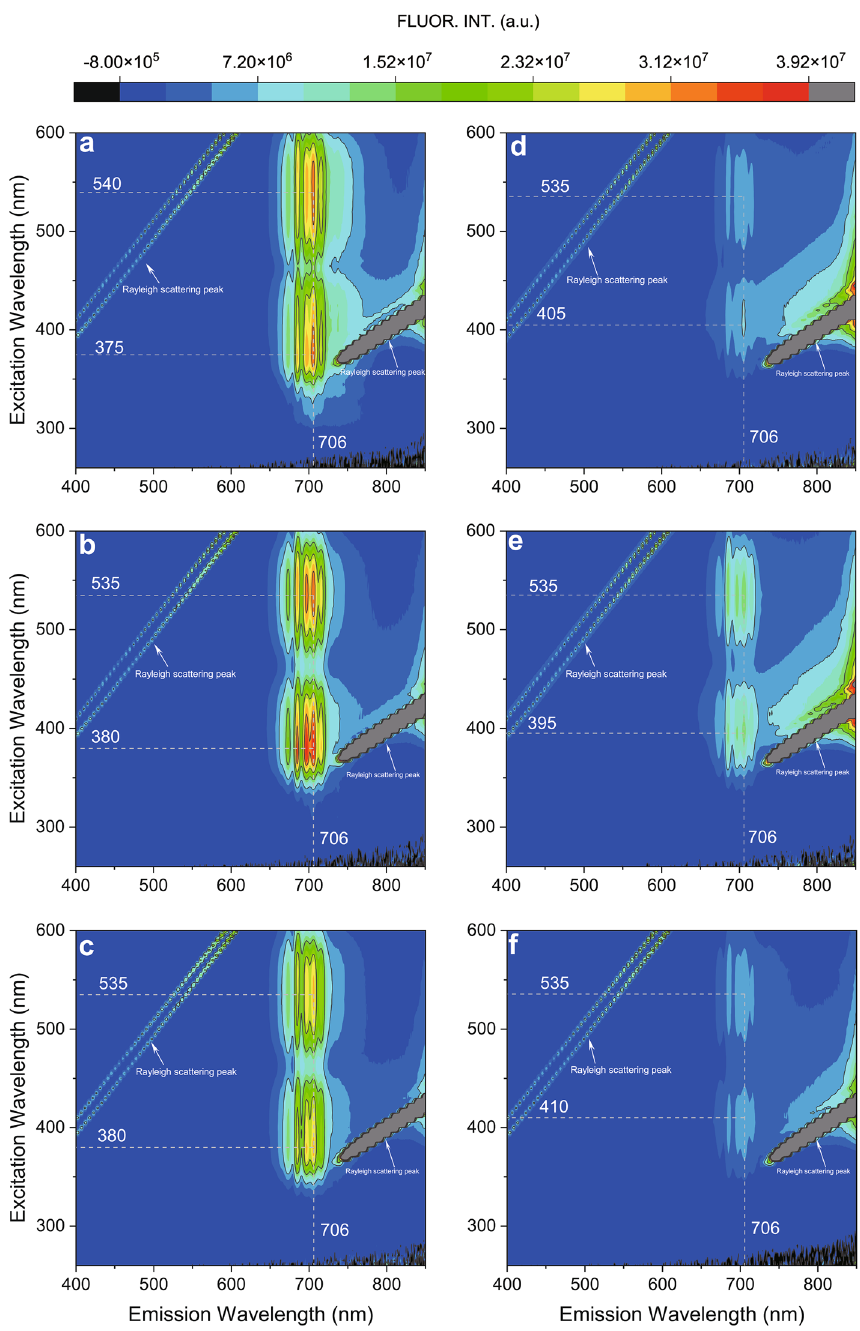
Figure 2. EEMs fluorescence spectra of the present spinels. Figure ( a )–( c ) on the left are the pinkish-red spinels (SPI-1 to SPI-3, respectively), and Figure ( d )–( f ) on the right are dark-red spinels (SPI-4 to SPI-6,